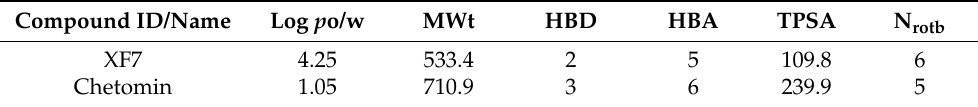
Table 2. Anticipated physiochemical characteristics of chetomin and XF7 as 3CL pro